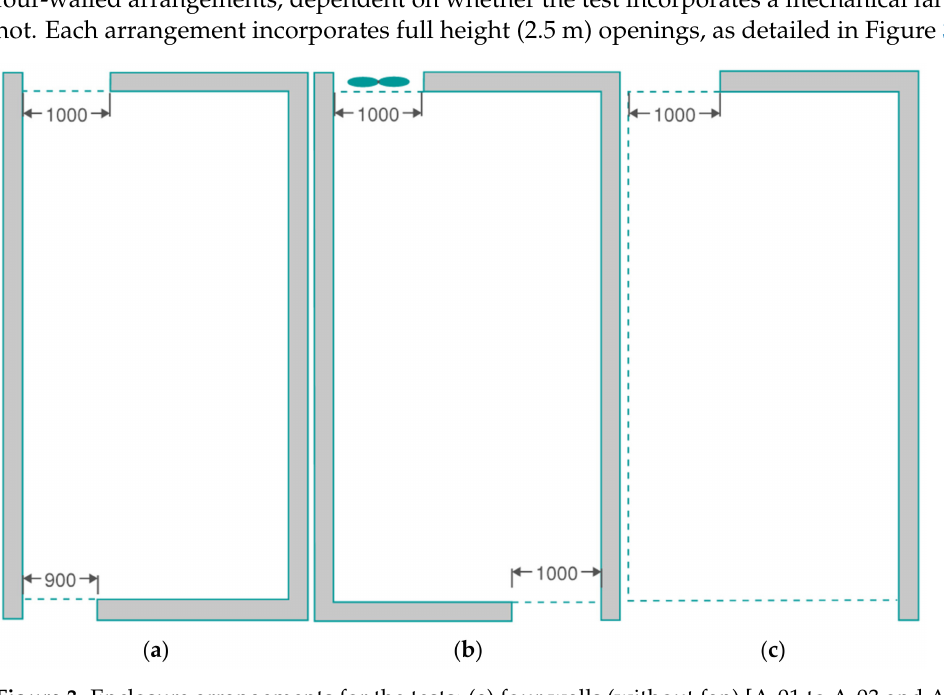
Figure 3. Enclosure arrangements for the tests: ( a ) four walls (without fan) [A-01 to A-03 and A-05 to A-06]; ( b ) four walls (with fan) [A-04 and A-08]; and ( c ) two walls [A-09 to A-11]. Solid wall obstructions are shown in grey with dashed green lines indicating openings. All dimensions in